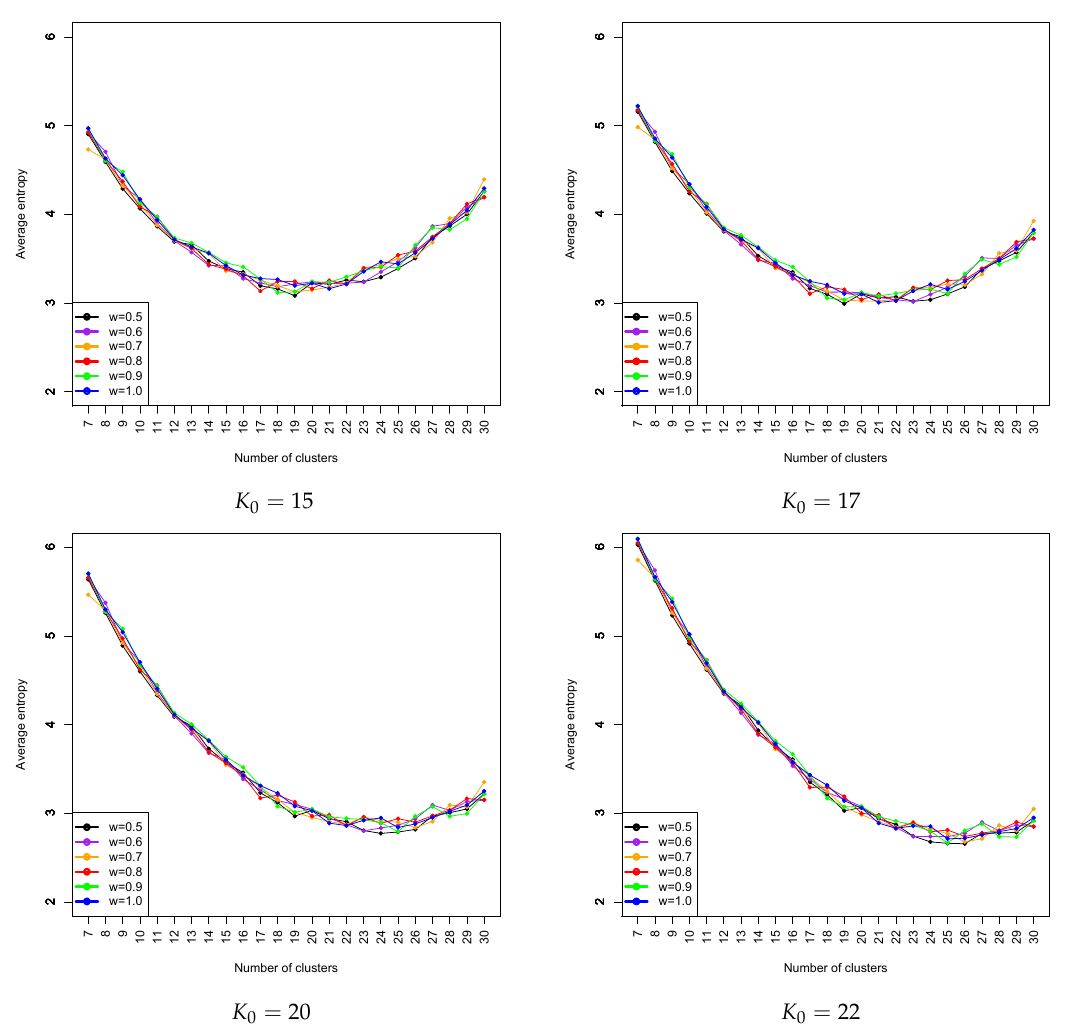
Figure 6. The results of penalized weighted average entropy for different choices of k 0 . The average entropy is weighted by exposures of each cluster. The optimal choice of K is K = 20, 21, 24 and 26, respectively, for K 0 = 15, 17, 20, and 22.